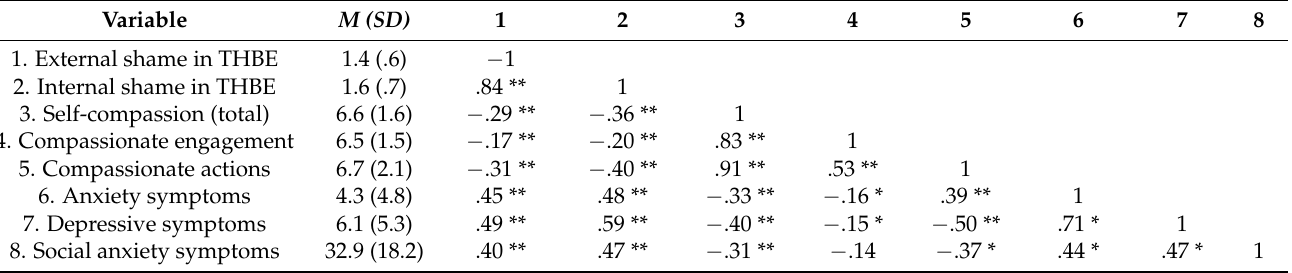
Table 2. Descriptive statistics and correlations between study variables ( N =